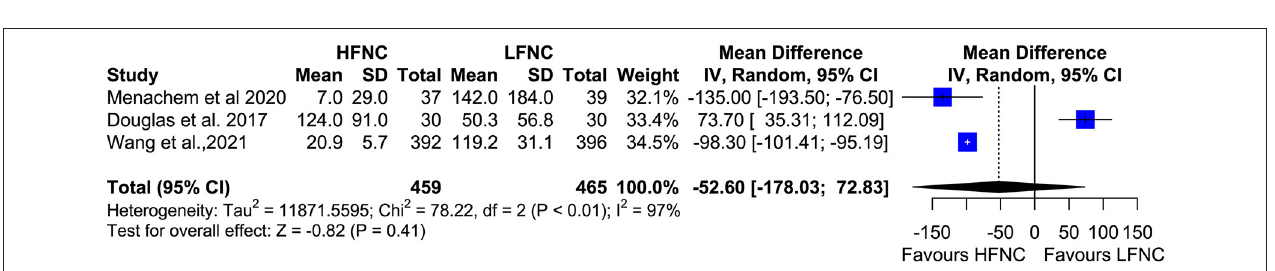
FIGURE 5 | Meta-analysis of lowest Sp02 in patients receiving HFNC compared to LFNC in patients undergoing bronchoscopic procedures.